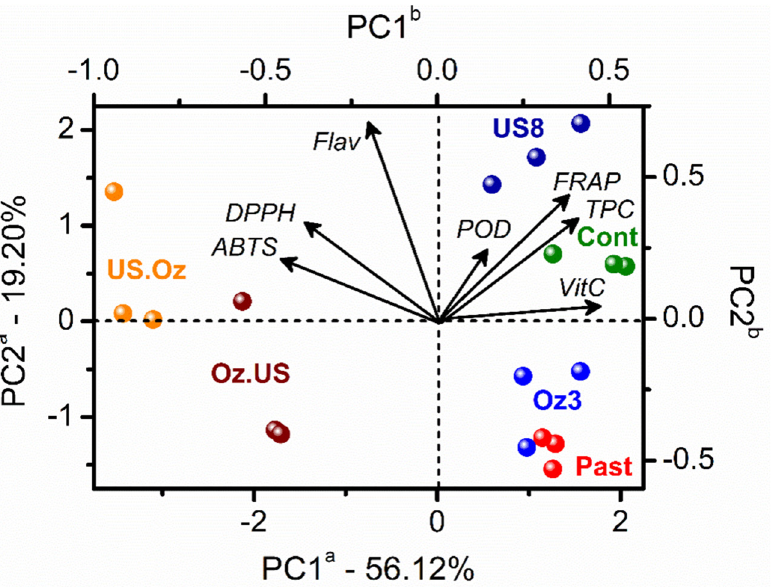
Figure 2. PCA biplot (scores and loadings) from cashew apple juices before (control in green color) and after thermal processing by PAST (red), and the sequential non-thermal processing by OZ (OZ3) followed by US (US8) and vice versa. See details in Table 1. The letter a in the PC axes refers to score axes, and b refers to loadings axes with variables represented by vectors from the origin.